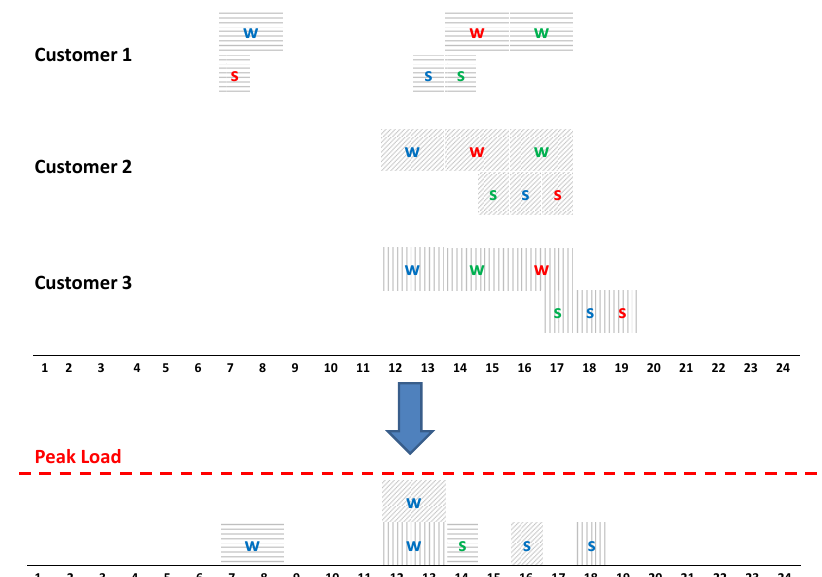
Figure 1. Illustration of the problem setup in the model. The upper part of the image shows the requests submitted by three households, each having two types of appliances (s,w). Boxes with different patterns are used to indicate different households. For individual appliances, we use the color code: blue, green and red corresponding to the maximal, medium, and minimal preference level, respectively. The lower part of the image shows the scheduled times for all of the